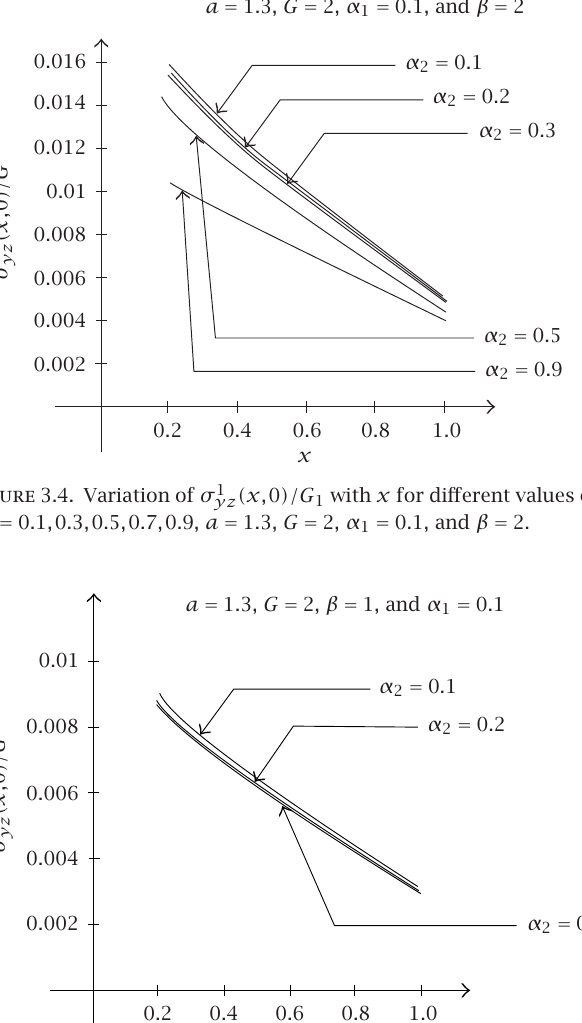
Figure 3.5 . Variation of σ 1 yz (x, 0 )/G α = 3 , 5 , 7 , 9, a = 1 . 3, G = 2, α 2